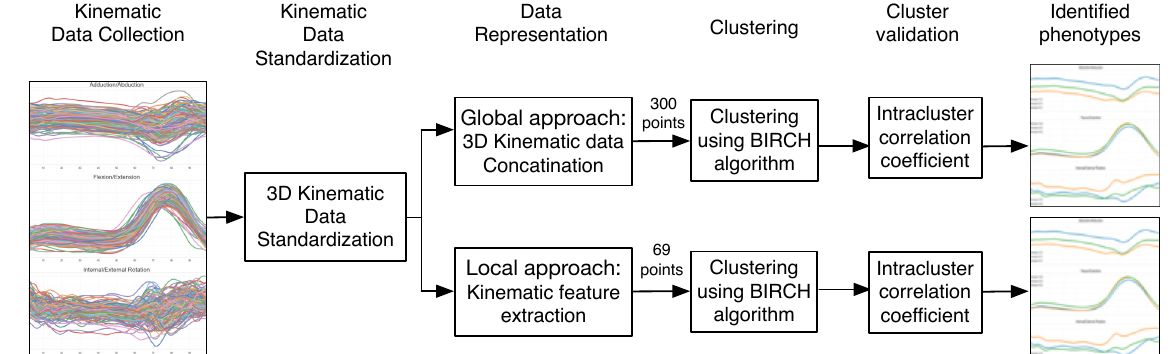
Figure 1. Block diagram of the adopted